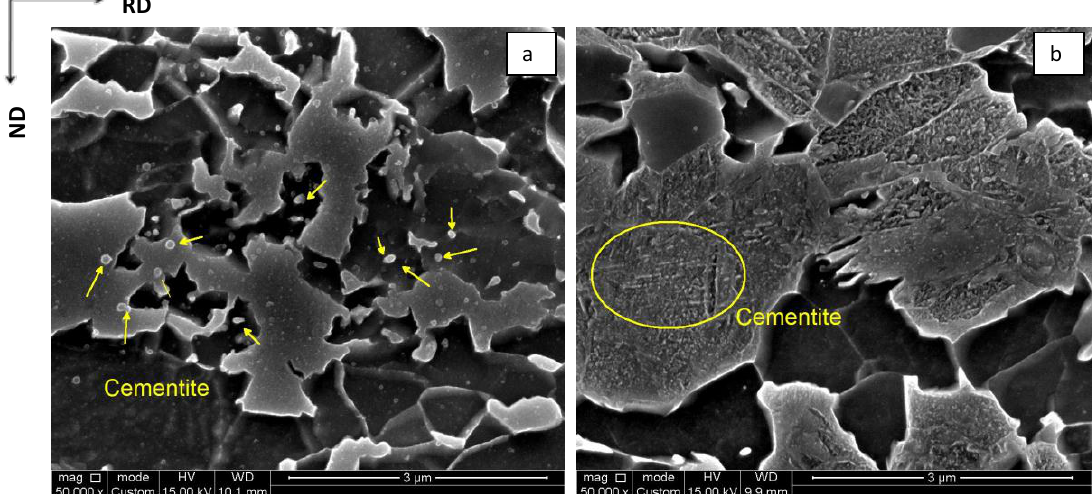
Figure 4. SEM images of a sample heated at 150 °C/s to 738 °C and quenched ( a ), and a sample heated at 1500 °C/s to 838 °C and quenched ( b ). The cementite is spheroidized in ( a ), whereas it still has a lamellar structure in ( b ). Etched with Nital 4%.